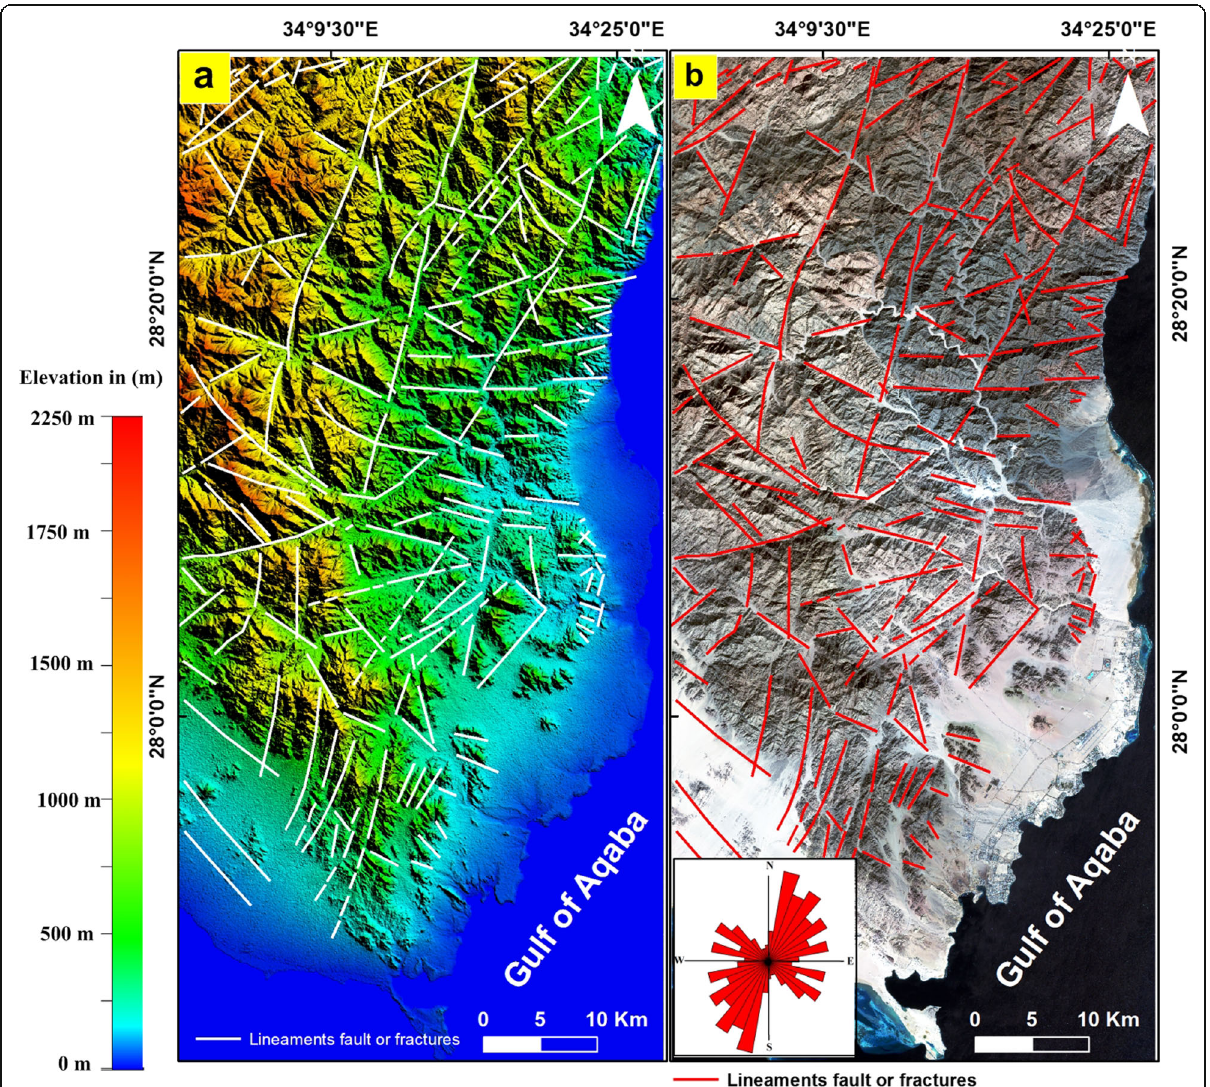
Fig. 7 Photo geologic structural lineaments map of the study area extracted from Landsat image 8 and the analysis of DEM derivatives including shaded relief map. Inset is the rose diagram showing the main trends of the extracted lineaments N-S, NW-SE, NE-SW. The lineaments are illustrated on ( a) DEM and ( b) Landsat